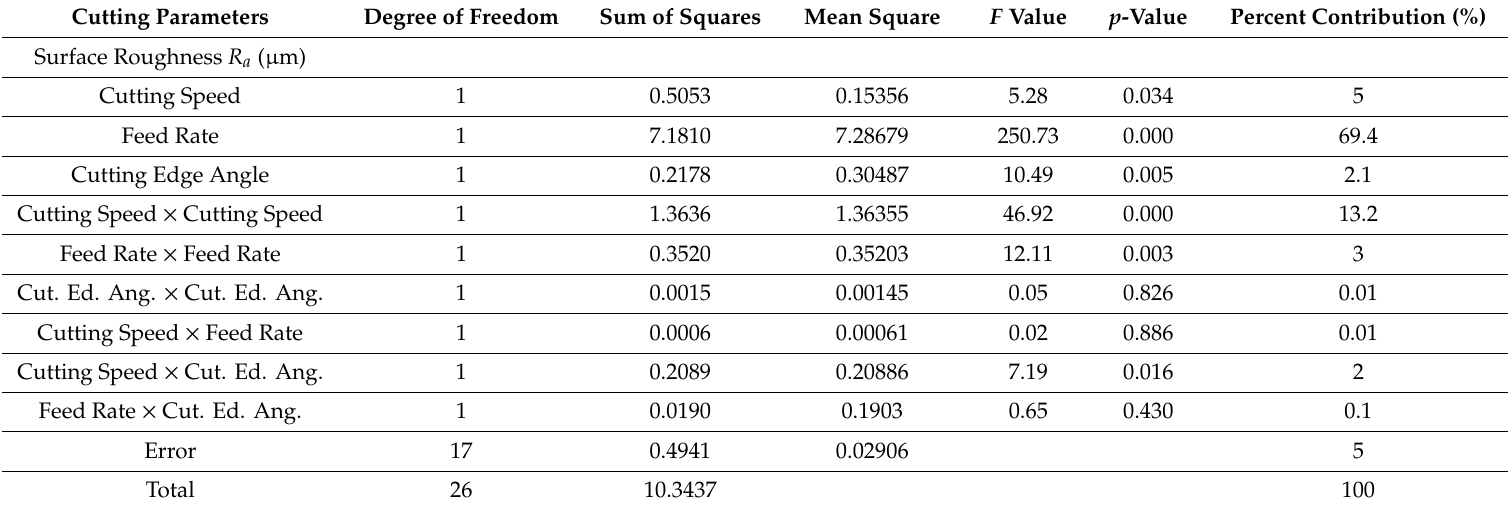
Table 5. ANOVA results for surface roughness.